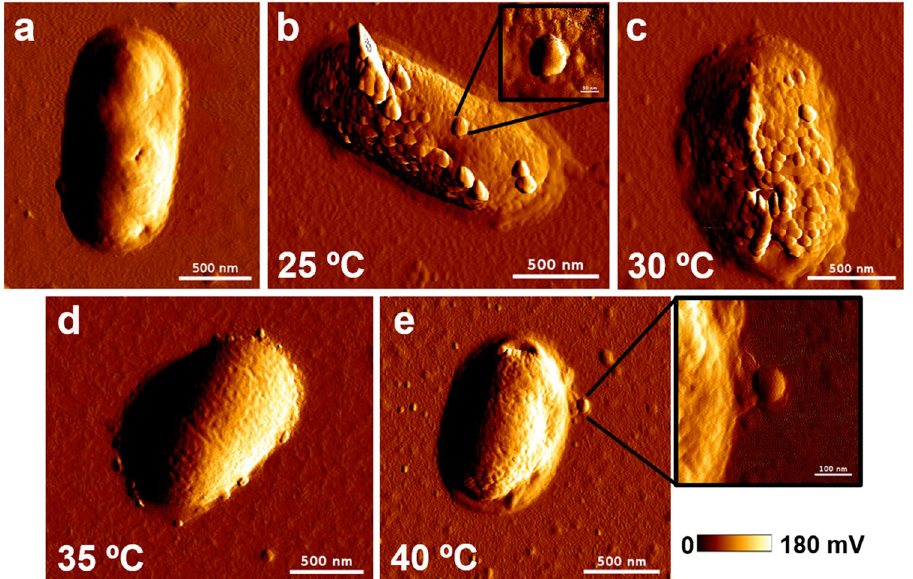
Figure 5. Exemplary AFM images of the C22 phage and Rs cells at different temperatures. ( a ) An AFM image of an Rs cell without the C22 phage. The C22 phage incubated at 25 °C ( b ), 30 °C ( c ), 35 °C ( d ), and 40 °C ( e ) mixed with Rs cells was investigated by AFM. Individual C22 phage particles could be distinguished in ( b , e ) insets. The color gradient scale bar was the scale of the vertical amplitude (Z-direction). The white scale bars in the ( a – e ) panels were 500 nm, and those in the inset were 100